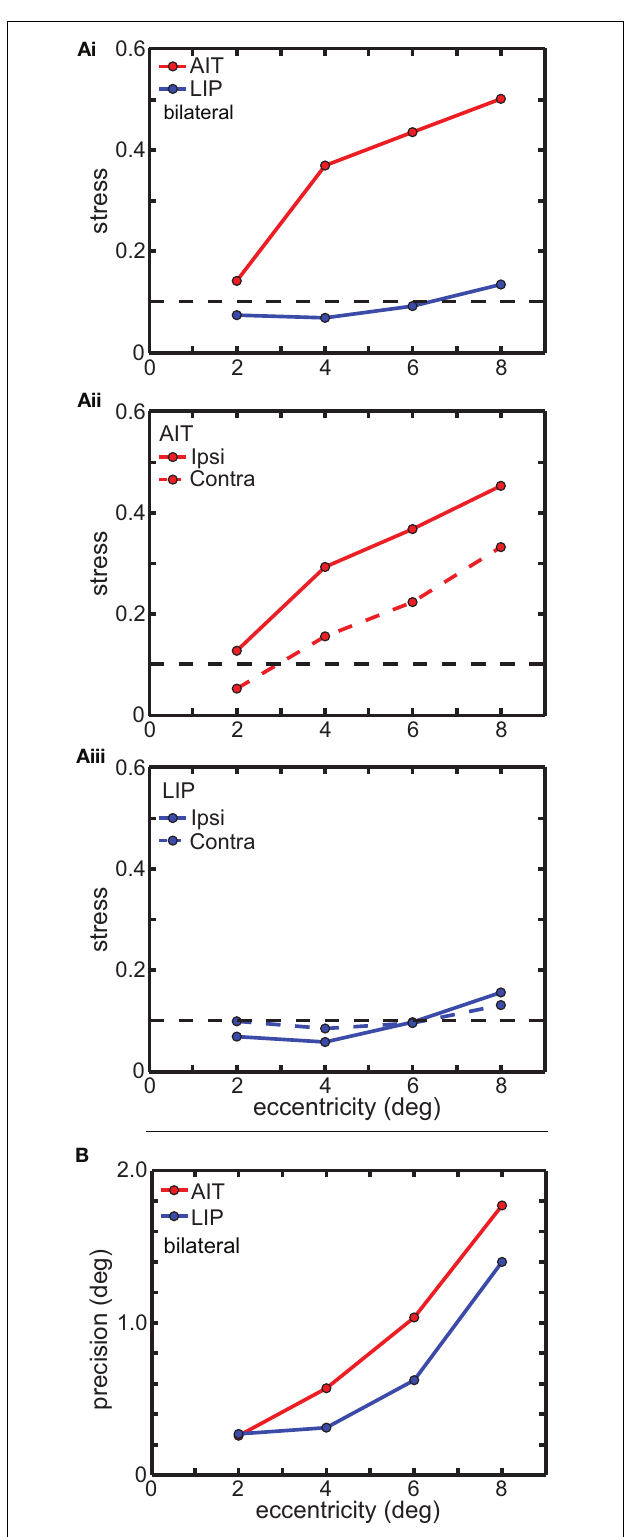
FIGURE 5 | Global and local error measures for multidimensional scaling analysis (MDS) results in Figure 3. (A) Global error (stress) as a function of stimulus eccentricity. Stress values below 0.1 (dashed linein